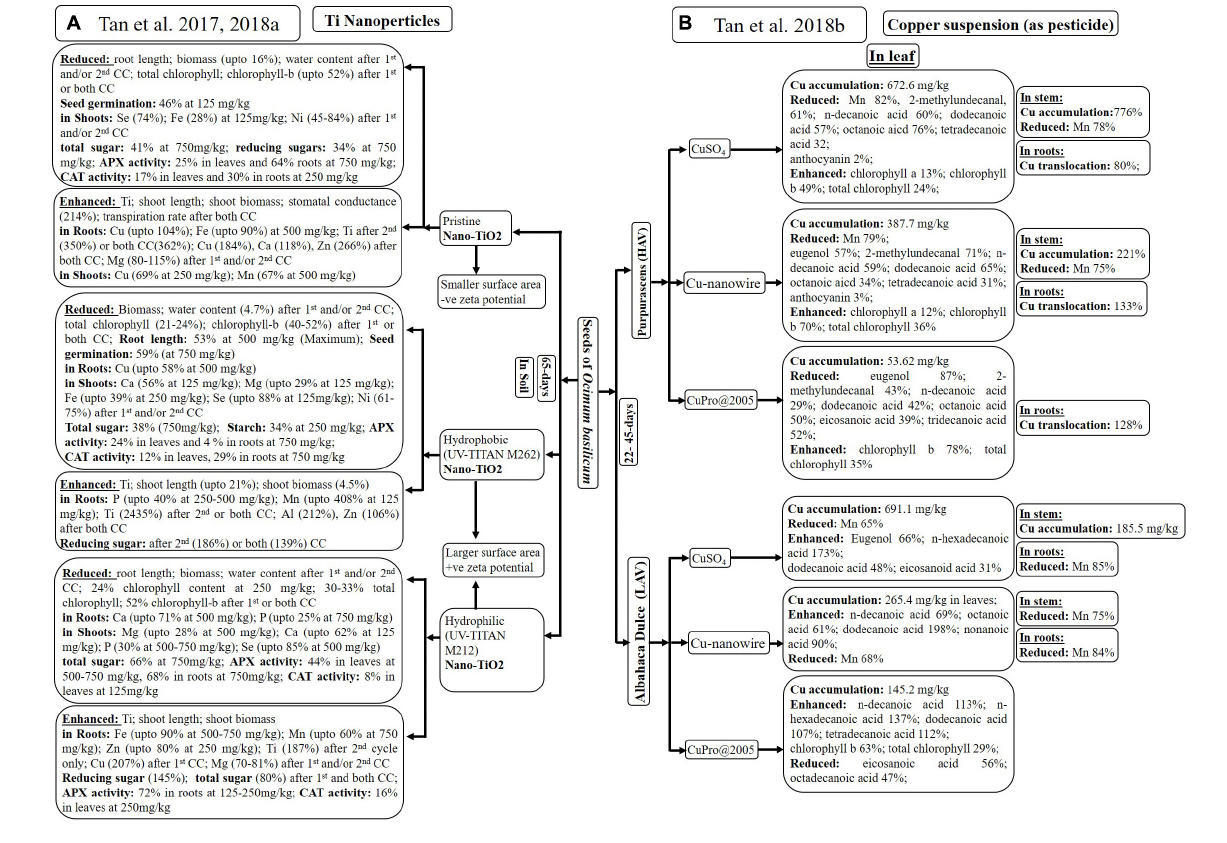
Frontiers in Plant Science |